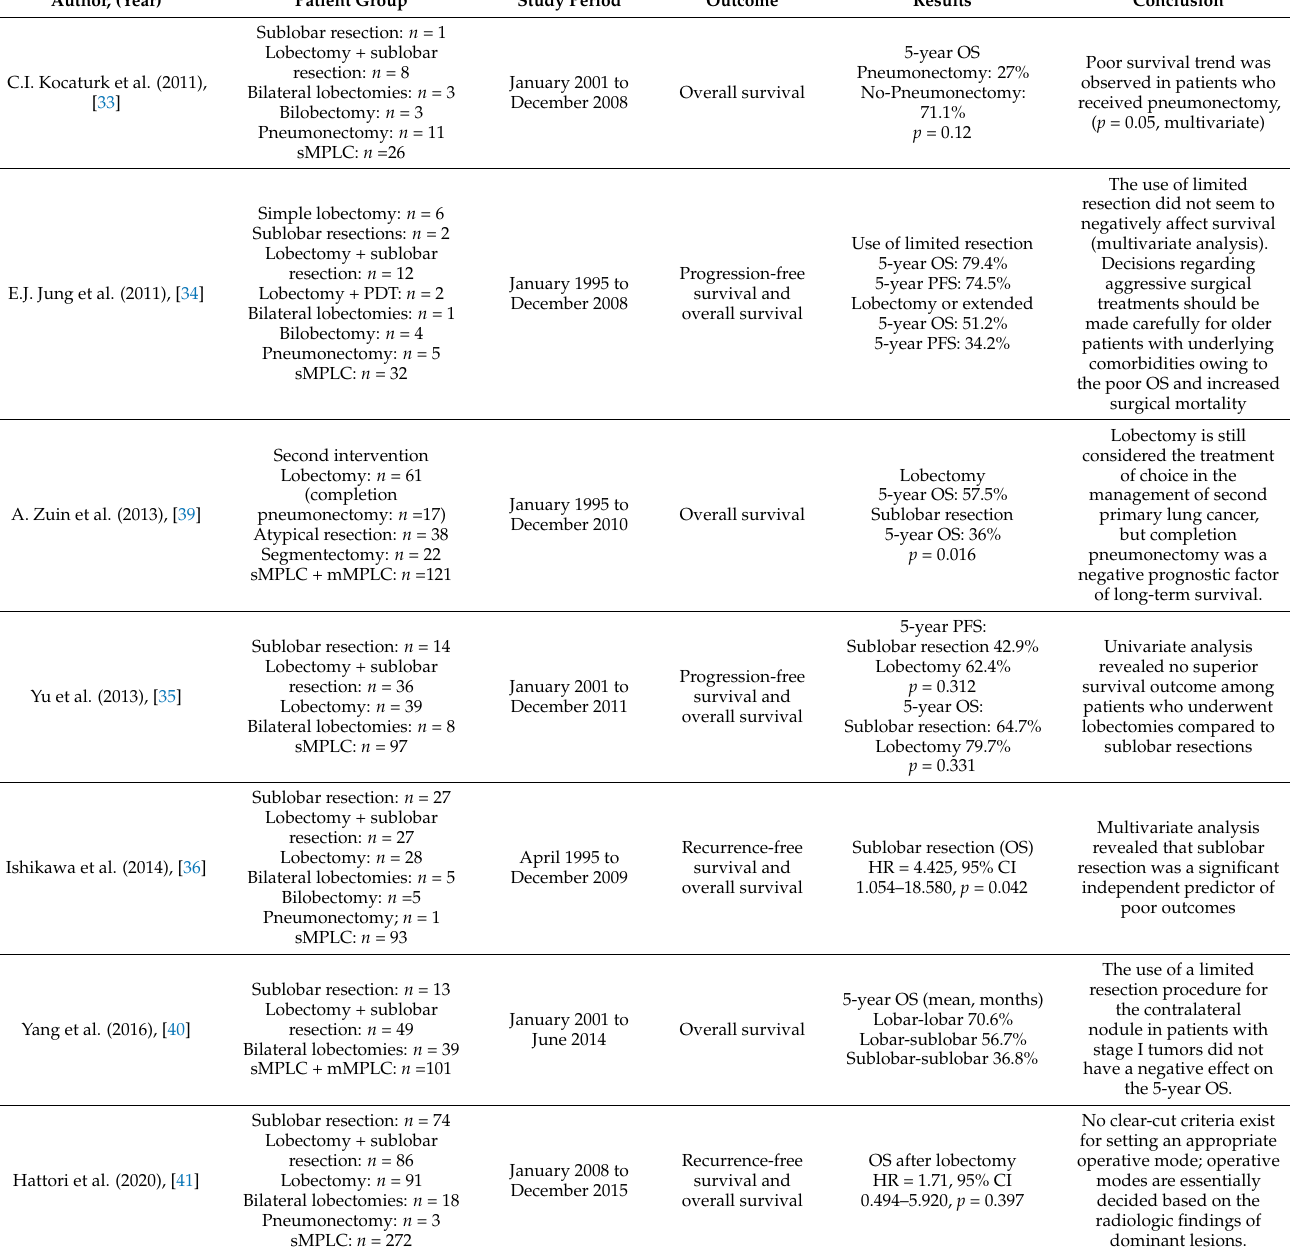
Table 1. Studies on the resection methods and outcomes of